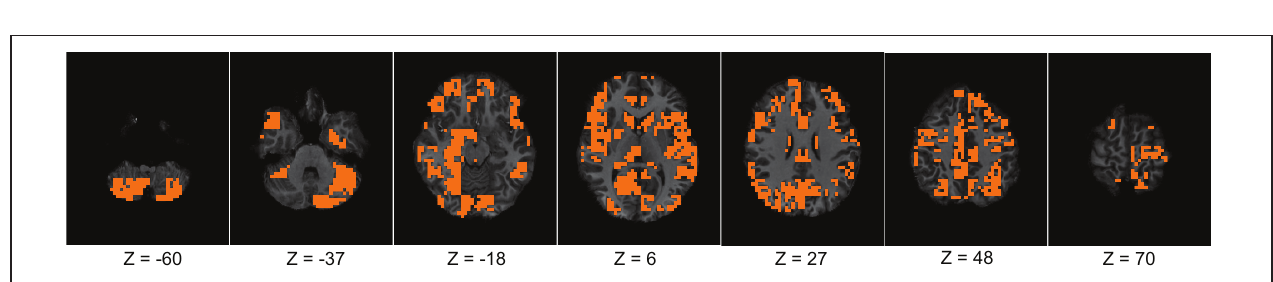
square regions marked in dark green. (c) Select the sub sets with top 10% of detection rate. (d) Generate a probability map based on the regions occurrence in top 10% subset. (e) Threshold the probability map to produce the useful region mask. (B) This part shows the flowchart for the mask generation algorithm.